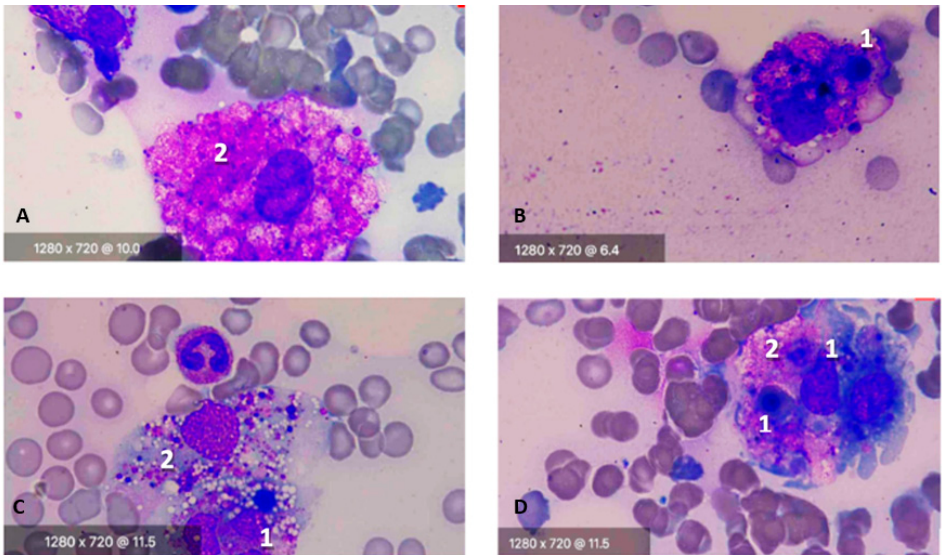
Figure 1. ( A – D ). Evidence of hemophagocytic elements and activated macrophages observed in bone marrow aspiration: macrophage with presence of phagocytized nucleated cells within the cytoplasm (1) and, above all, platelets (2) (100× magnification).